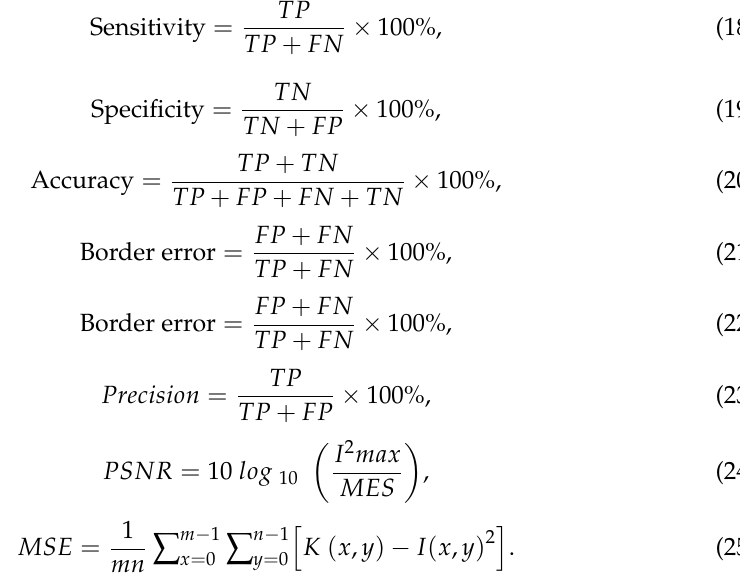
( f ) ( g ) Figure 10. Detection of malignant Sample. ( a ) Input CT Image, ( b ) Pre-processed Output image, ( c ) Histogram Equalised Image Plot, ( d ) Histogram Equalised Image, ( e , f ) Segmentation image, ( g ) Classification result. Table 5. Parameter calculation of nodules. Region